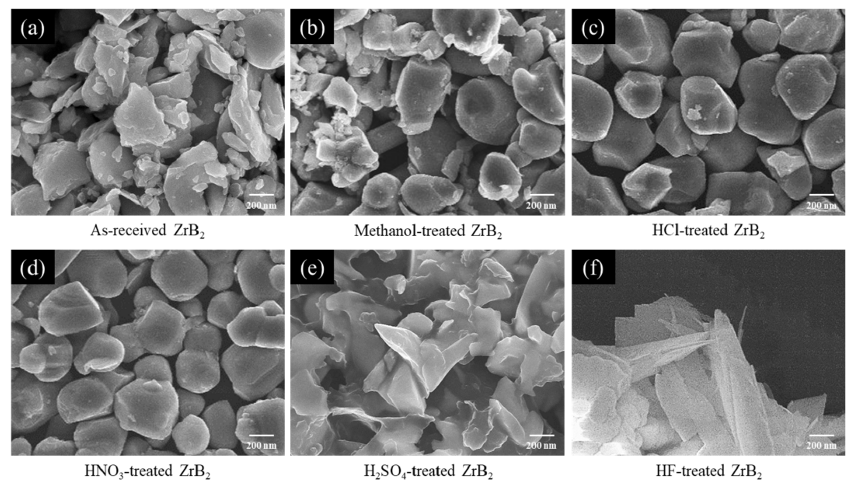
Figure 2. Scanning electron microscopy (SEM) images of ( a ) as-received ZrB 2 , ( b ) methanol-treated ZrB 2 , ( c ) HCl-, ( d ) HNO 3 -, ( e ) H 2 SO 4 -, and ( f ) HF-treated ZrB 2 particles.